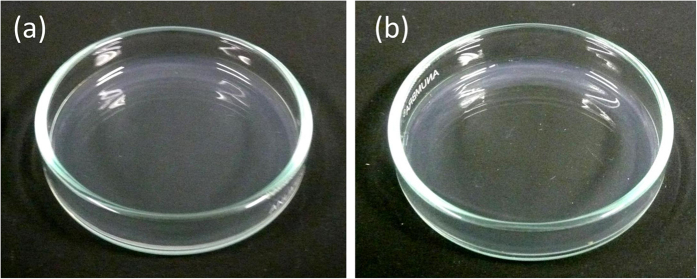
Pictures of an agar gel of average thickness 1 mm, cast in a Petri dish of 50 mm diameter made of glass: (a) prior to the drying experiment, and (b) 8 hours after the start of the drying experiment at T = (21.0 ± 0.5) °C. The complete drying occurs first at the center of the dish, which suggests a slightly larger thinning rate of the gel at the center of the dish, as quantified in Fig. 4.